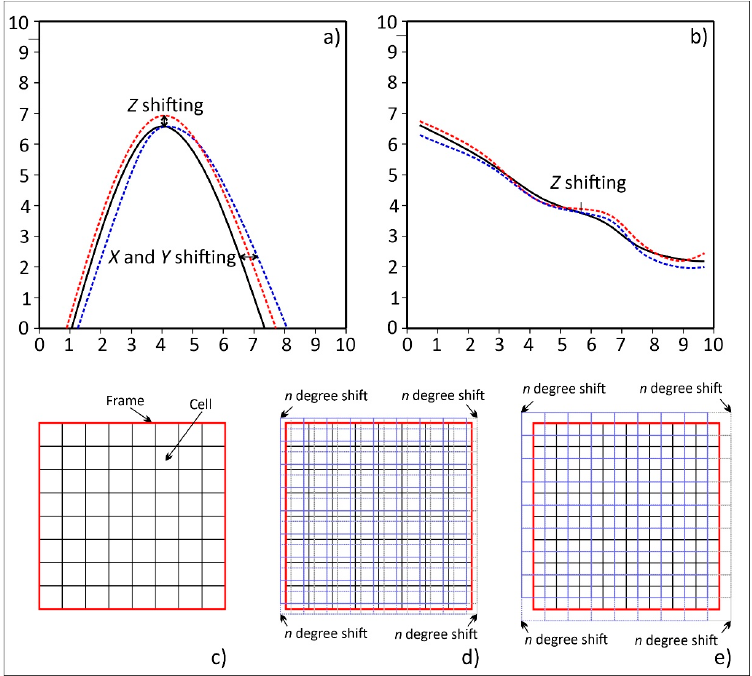
Figure 8. Conceptual model displaying the RMS shifts on all three axes and their in fl uences in the earth volume displacements. Upper row, RMS shifts are presented on transversal and longitudinal pro fi les. In the lower row, from left to right, RMS shifts with increasing values are presented: ( a ) vertical shifting seen from a transversal pro fi le; ( b ) vertical shifting seen from a longitudinal pro fi le; ( c ) original grid; ( d ) n degree shifted grid with low RMS; ( e ) n degree shifted grid with high RMS. The baseline for each simulation was considered the DEM obtained per each fl ight.